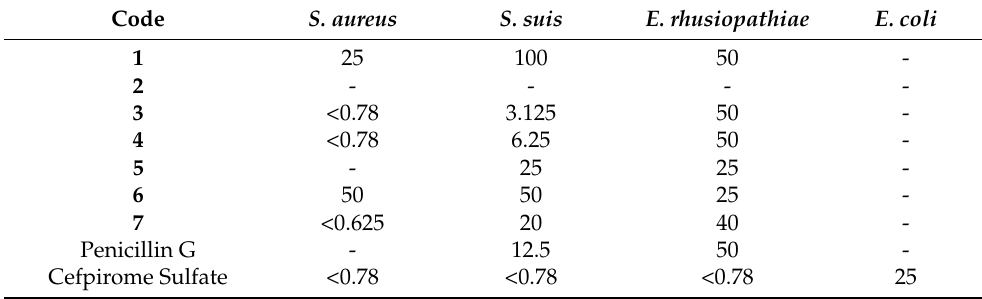
Table 4. Antibacterial activities of compounds 1 – 7 (MIC µ